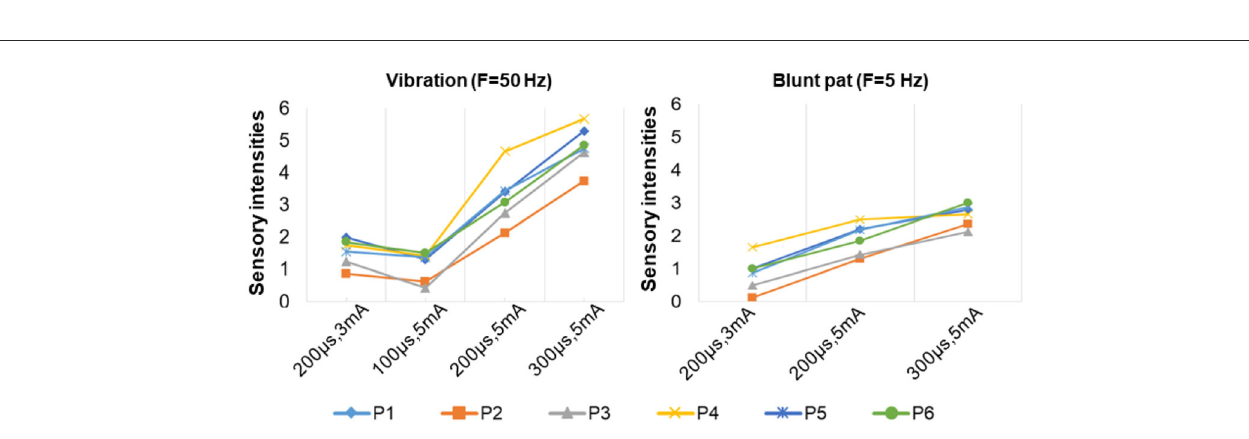
relationship between stimulus positions and sensation positions. It is almost consistent with the result obtained in the SS pattern. The stable sensations of the thumb and little finger were evoked at P2 and P6 with a probability of 100%. A slight difference in the sensation of the index finger was also evoked on P6 at a small frequency of